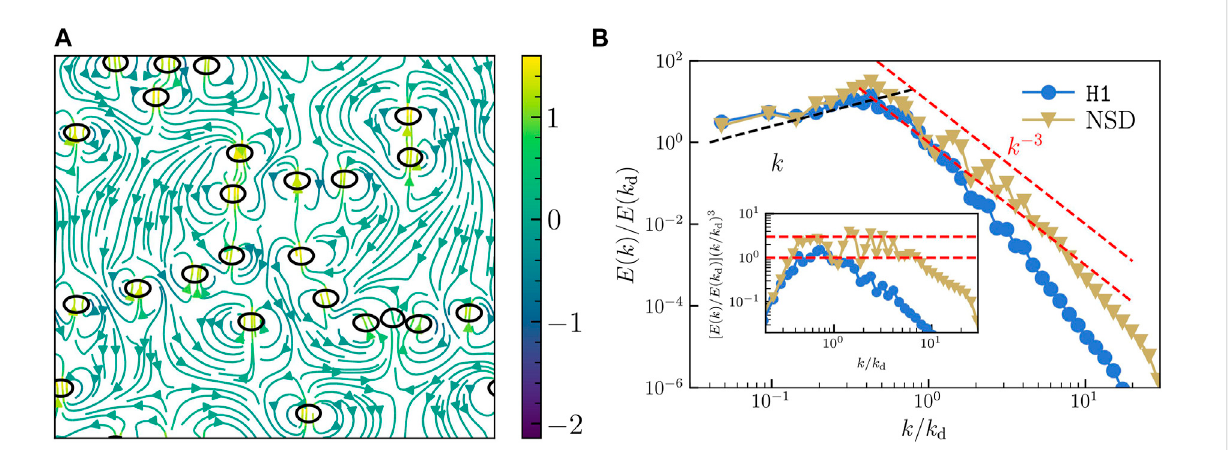
FIGURE 7 (A) Snapshotofthebubblepositionsoverlaidwith fl owstreamlines. (B) Comparisonofthegap-averagedenergyspectraforourNSHSrun H1 withthe energyspectraobtained usingsimulationoftheNSDEq.5.(Inset)Thecompensatedspectra k 3 E ( k )isdrawnto highlightthe − 3scalingrange observedfor H1 and NSD simulation.